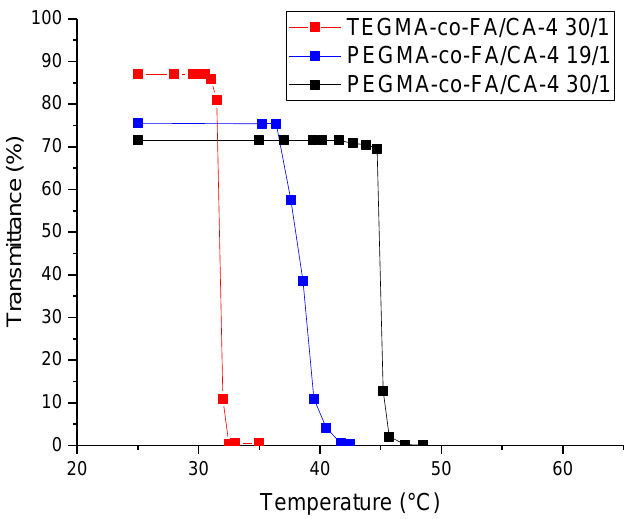
Figure 6. Turbidimetry measurements (λ = 700 nm) in water of polymer/drug systems TEGMA- ran - FA/CA4 30/1, PEGMA- ran -FA/CA4 30/1, and TEGMA- ran -FA/CA4 19/1.